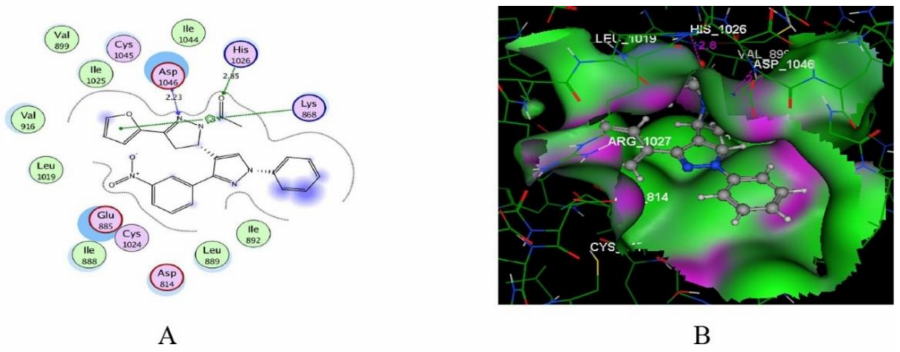
Figure 95. Compound 91 binding mode in the active pocket of VEGFR-2, ( A ) illustrates the 2D interaction and ( B ) the 3D interactions. Green = hydrophobic area, pink = high polar area, blue = mild polar area and dotted lines and arrows = hydrogen bonds